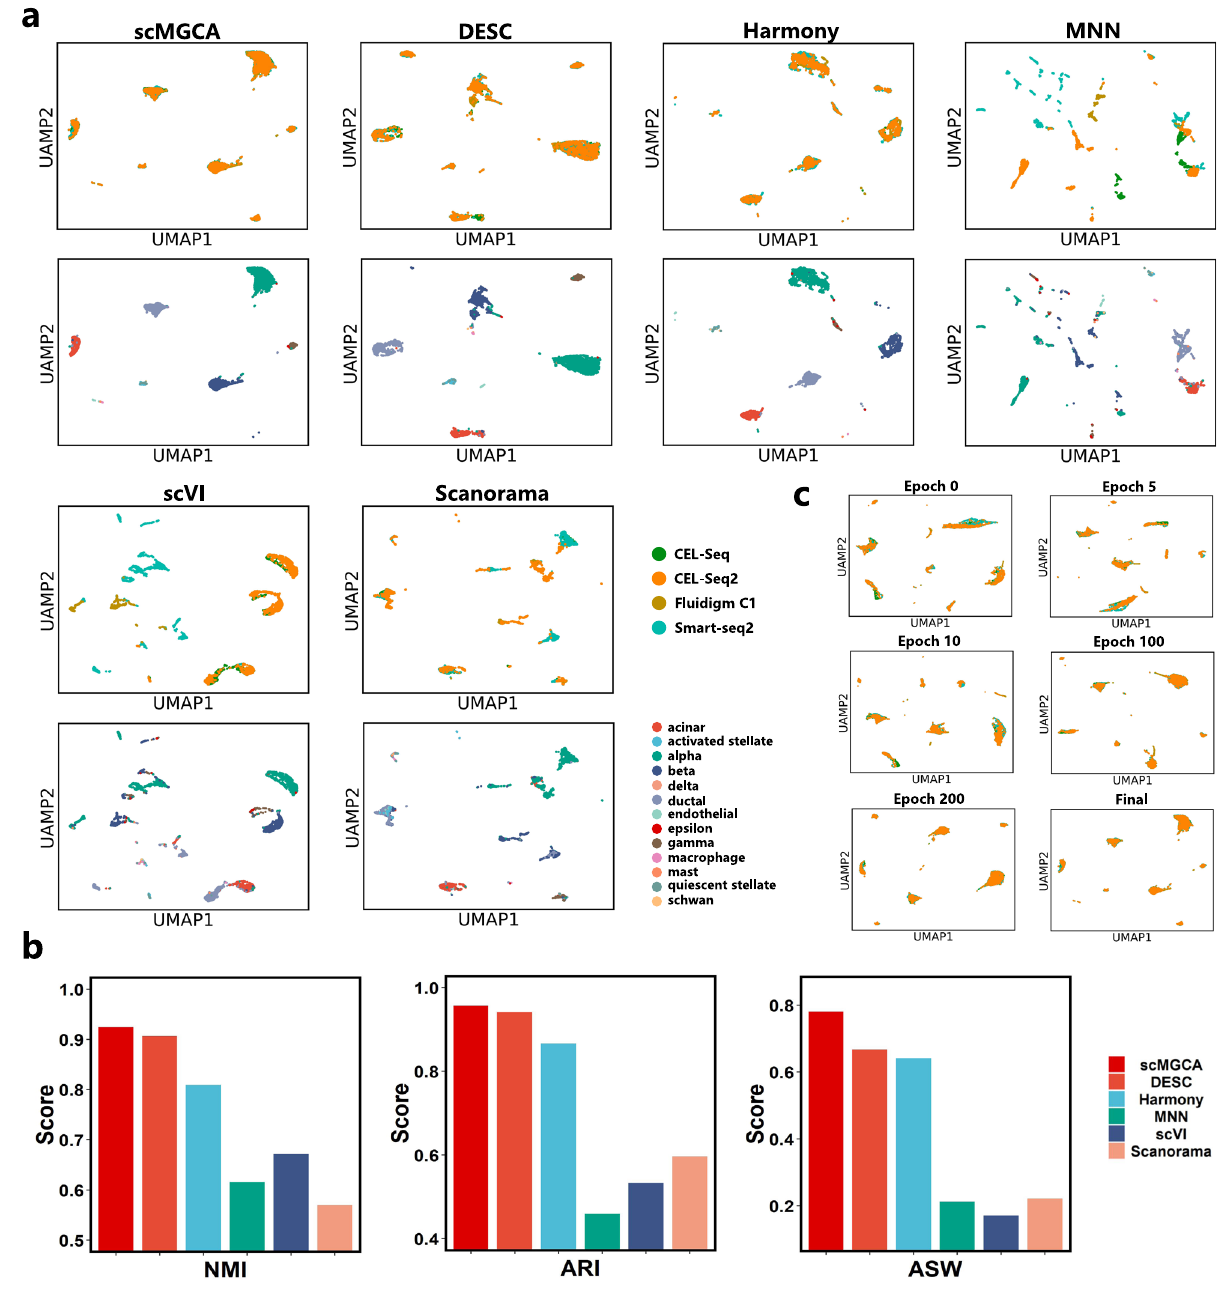
Fig. 4 | Comparison of batch effect correction methods on the pancreatic islet data generated by different scRNA-seq protocols. a Visualizing scMGCA with different methods for batch effect correction via UMAP. The cell batches are coloredinthetoprowandcelltypesinthebottomrow. b Comparisonofclustering